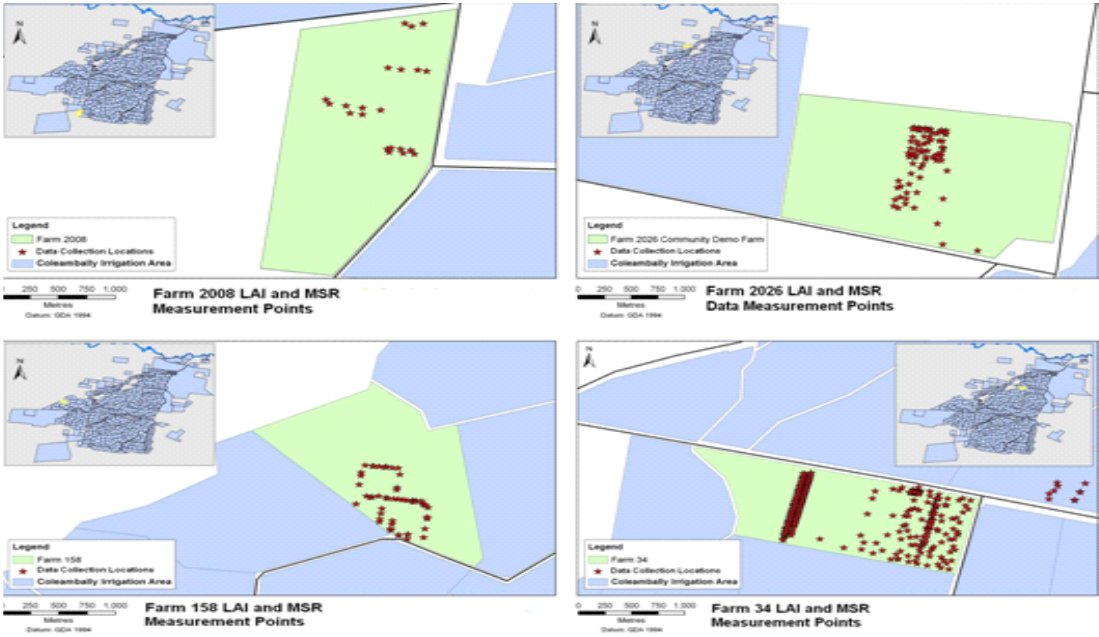
Figure 2: Spectral and LAI data collection sites at various CIA locations